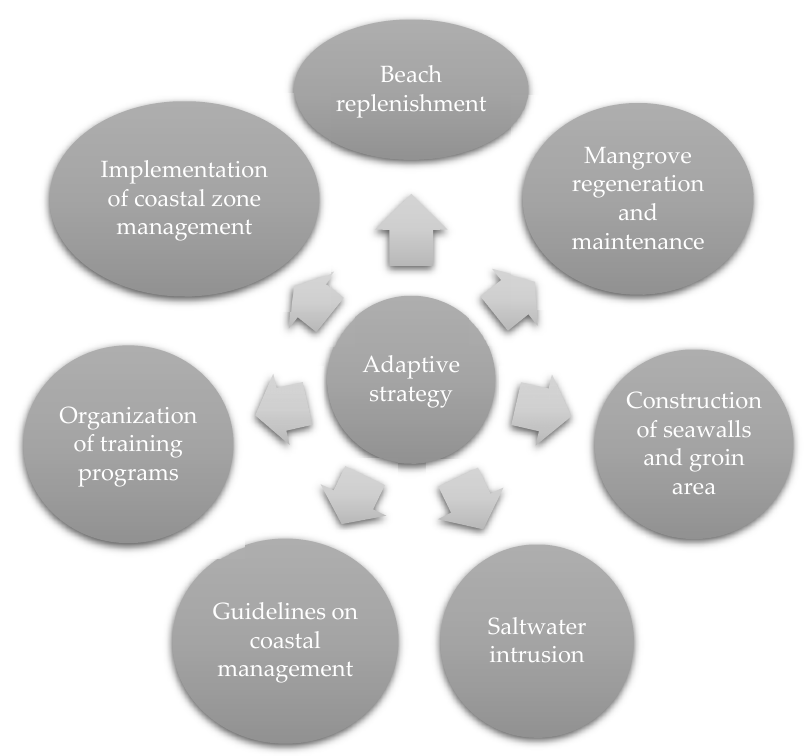
Figure 4. Suggestion of adaptive strategies in coastal vulnerability.